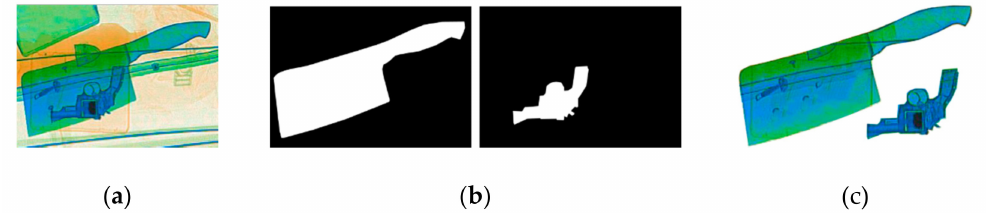
Figure 2. Object separation. ( a ) Input image. ( b ) Binary masks for each target object. ( c ) Isolated objects using the binary masks (for